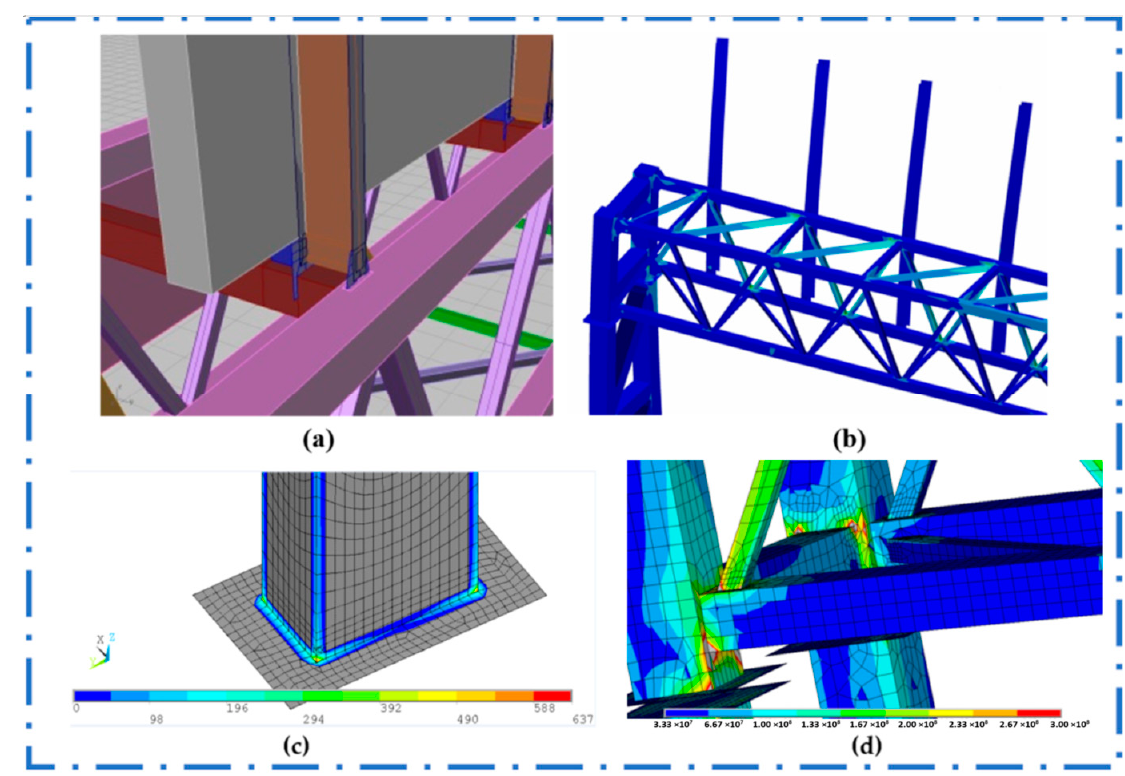
Figure 14. ( a ) Local/detailed CAD model of gantry boom, ( b) its high-resolution zonal stress results, ( c ) fatigue calculation for baseplate welding, and ( d ) boom-leg joints.